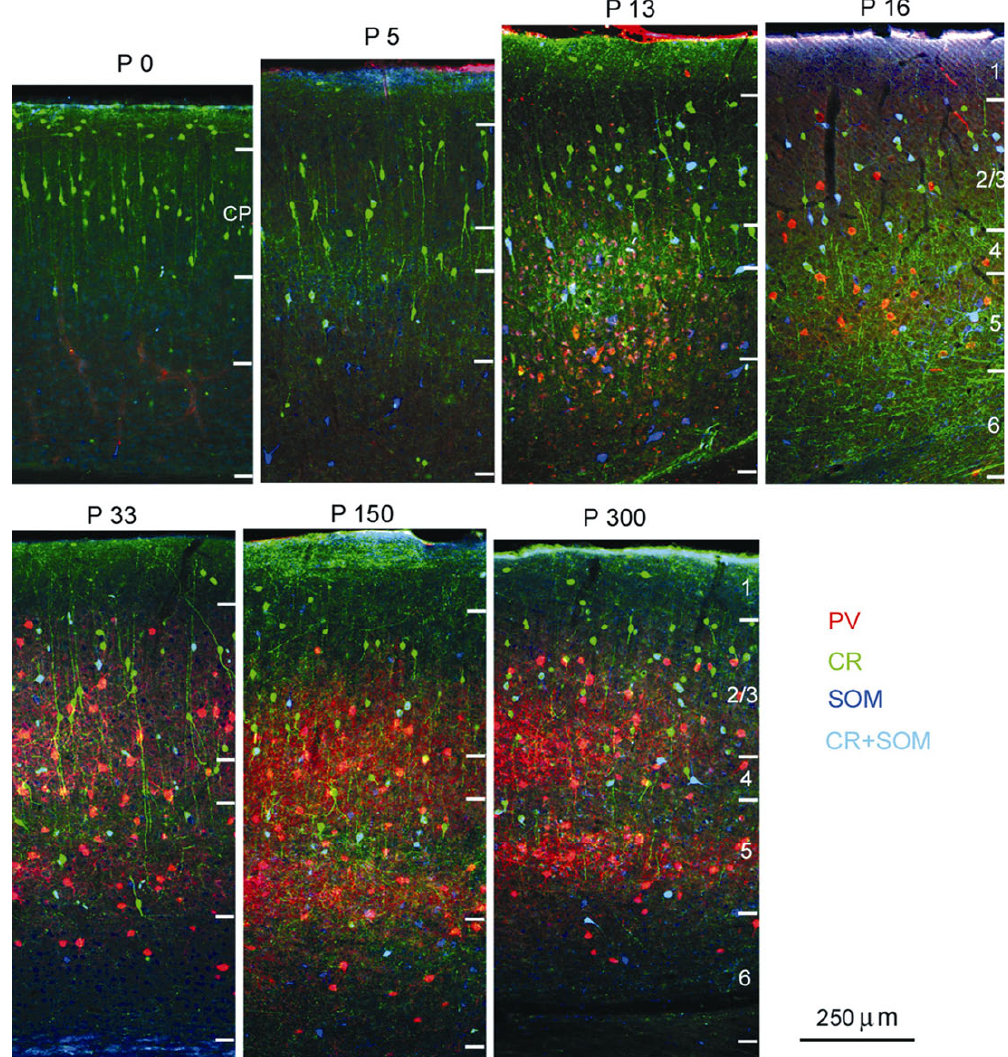
Figure 6. Triple immunolabeling with antibodies against PV, CR and SOM in coronal sections of developing mouse visual cortex. P0 indicates day of birth. P13 represents the day before eye opening. P16 corresponds to the second day after eye opening. CR expression is present at birth. SOM expression emerges at ~P5. CR + SOM coexpression (light blue) is present from the onset of SOM expression. PV expression emerges at